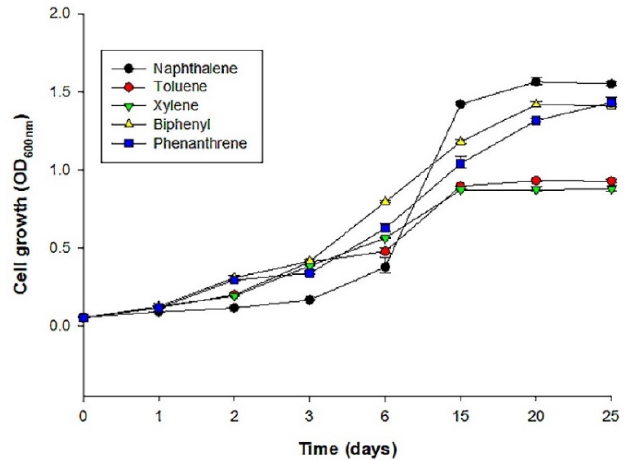
Figure 1. Growth of S. yanoikuyae S72 in tested hydrocarbons. Bacteria’s growths were measured as optical density (600 nm) in liquid Bushnell Haas medium supplemented with each of the five different hydrocarbons (100 µg/mL) as sole source carbon for 25 days.